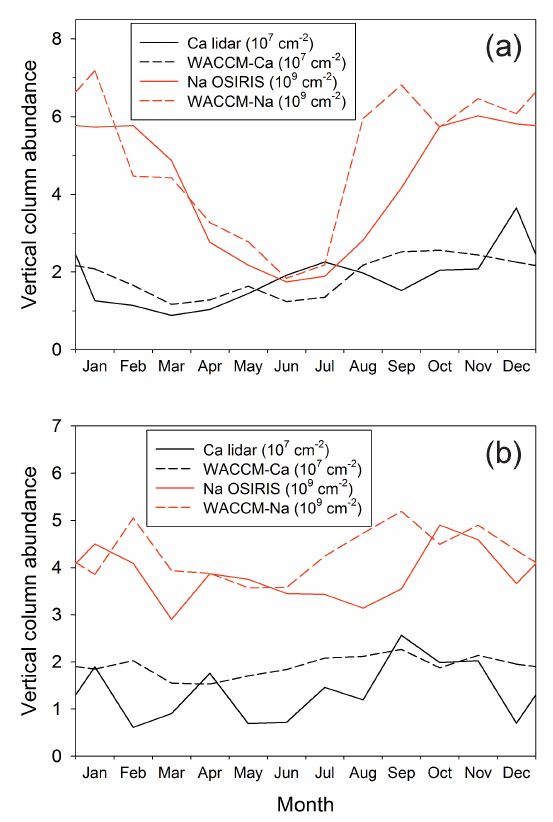
Figure 6. Comparison of observed and modelled Ca and Na ver- tical column abundances: (a) at Kühlungsborn (54 ◦ N) and (b) at Arecibo (18 ◦ N). The Na column observations were made with the Osiris spectrometer on the ODIN satellite (Fan et al.,